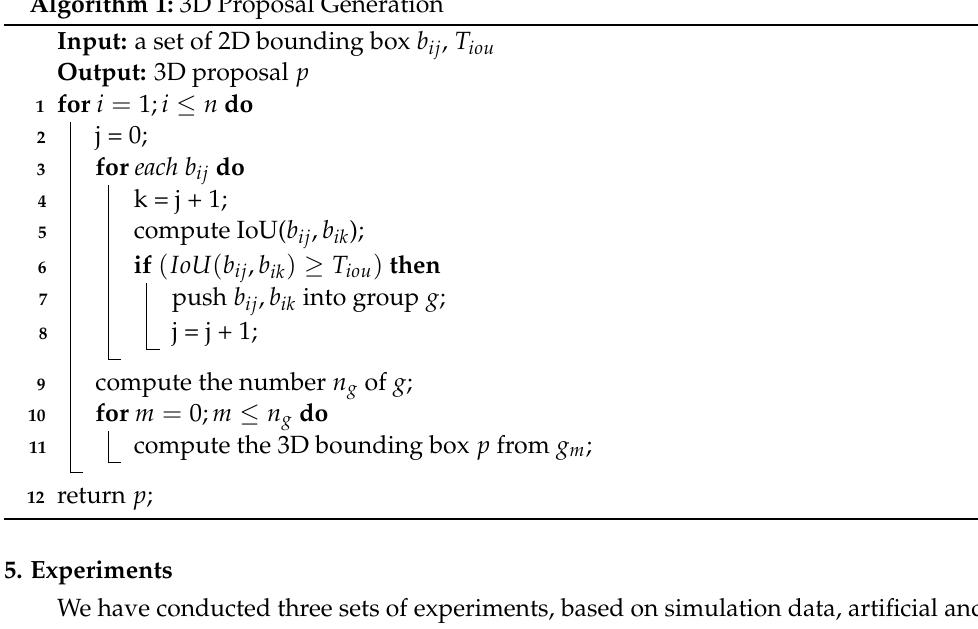
Algorithm 1: 3D Proposal